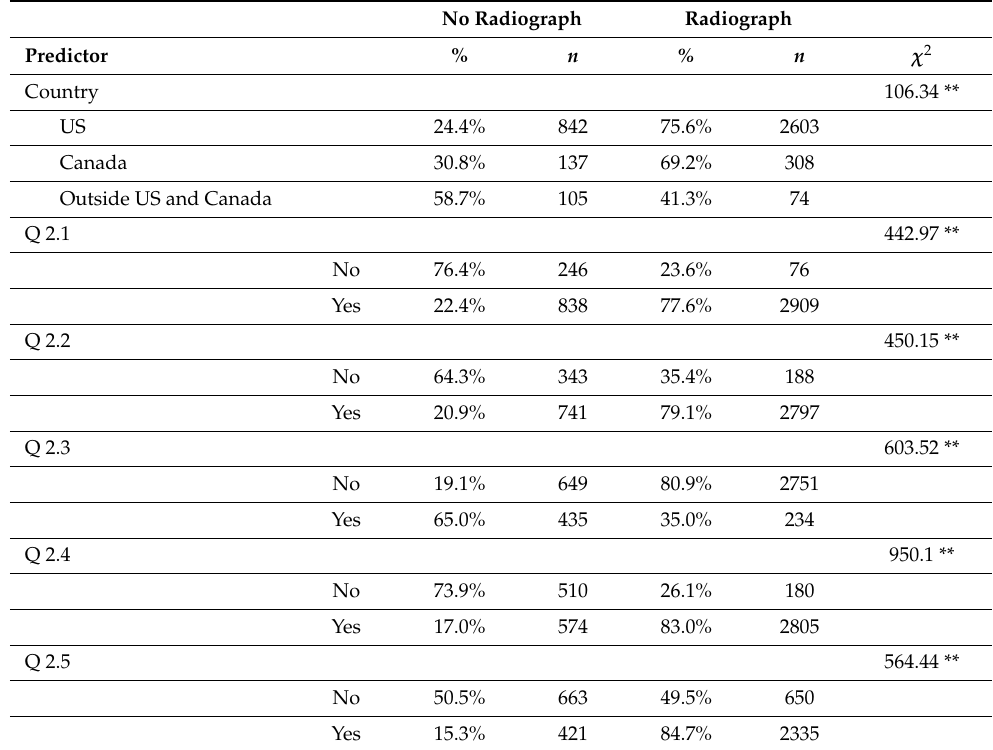
Table 4. Percentage of respondents who do and do not obtain radiographs in their